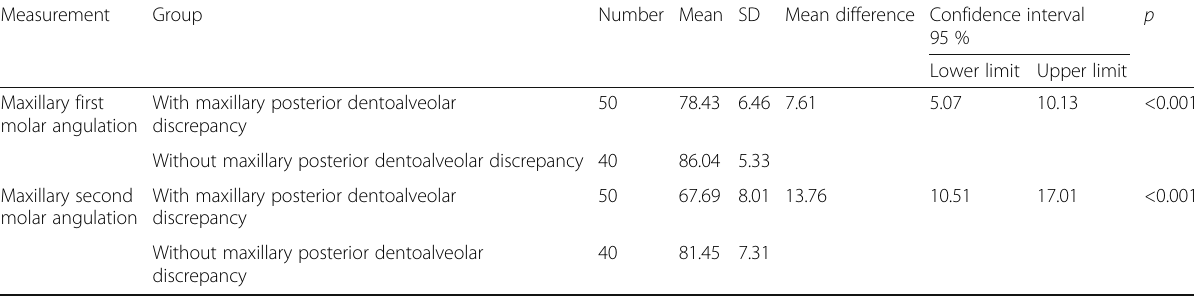
Table 5 Maxillary molar angulation according to maxillary posterior dentoalveolar discrepancy Measurement